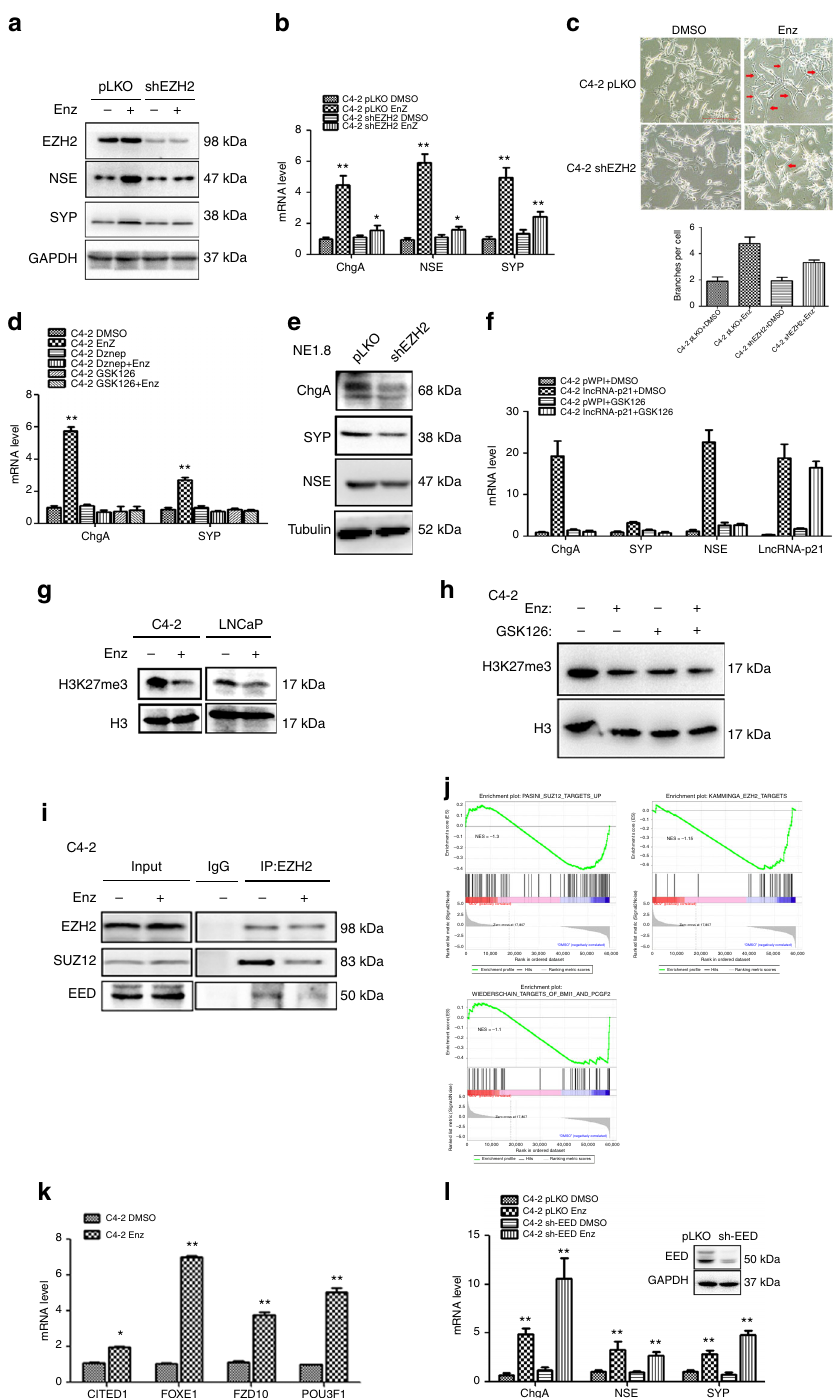
Fig. 3 EZH2, but not the PRC2 complex, is essential for Enz treatment induced NED. a , b Enz-increased NE markers were reduced after EZH2 knockdown. The C4-2 pLKO control and shEZH2 cells were treated with/without (w/o) 10 μ M Enz for 4 days, and the NE markers detected by ( a ) western blot (WB) and ( b ) qPCR. c EZH2 knockdown can reverse the Enz-induced NED. The C4-2 pLKO and shEZH2 cells were treated w/o Enz for 7 days, then the cell morphology was observed under microscope, quantitations in lower panel. (Scale bar = 20 μ m). d EZH2 inhibitors can inhibit the expression of NE markers. C4-2 cells were treated w/o Enz and EZH2 inhibitors (4 μ M GSK126 and 1 μ M Dznep) for 4 days, and the mRNAs of NE markers analyzed by qPCR. e Expression levels of NE markers in NE1.8 cells after knocking down EZH2. f C4-2 pWPI and pWPI-lncRNA-p21 cells were treated w/o 4 μ M GSK126, and the NE markers levels detected by qPCR. g H3K27me3 levels in C4-2 cells after treating w/o Enz for 4 days. h H3K27me3 levels in C4-2 cells after DMSO, Enz and GSK126 treatment. i Co-IP assay to detect the interaction between EZH2, SUZ12 and EED in C4-2 cells w/o Enz treatment for 4 days. j GSEA of PRC2 and EZH2 pathway enrichment in C4-2 cells after Enz treatment. k Expression of PRC2 complex target genes in C4-2 cells after 4 days of Enz treatment. l The mRNA levels of NE markers in C4-2 pLKO control and C4-2 shEED cells after Enz treatment for 4 days. For b , d , f , k , the data are presented as mean ± SD, * p < 0.05, ** p < 0.005, by t-